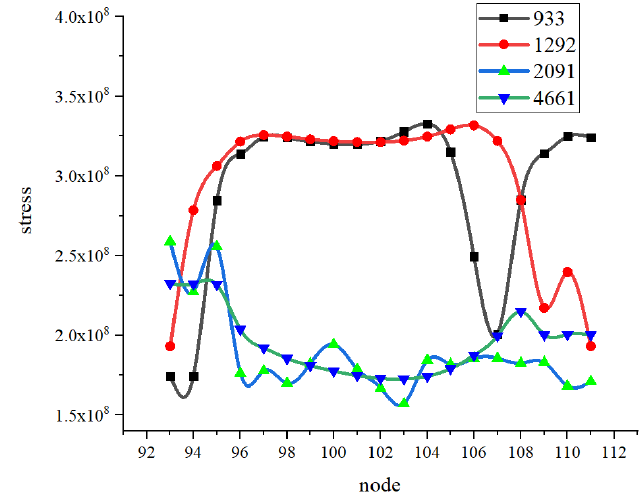
Figure 17. Stress data output of different grid numbers.